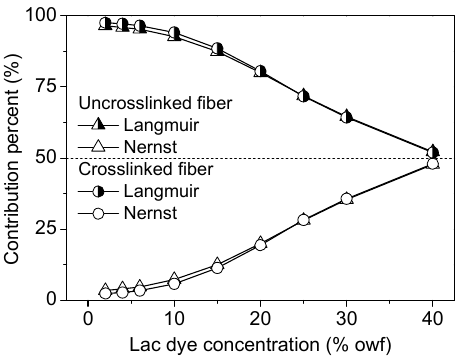
Figure 5. Contribution of Langmuir and Nernst adsorption to lac dye adsorption on the uncrosslinked and crosslinked chitosan fibers.